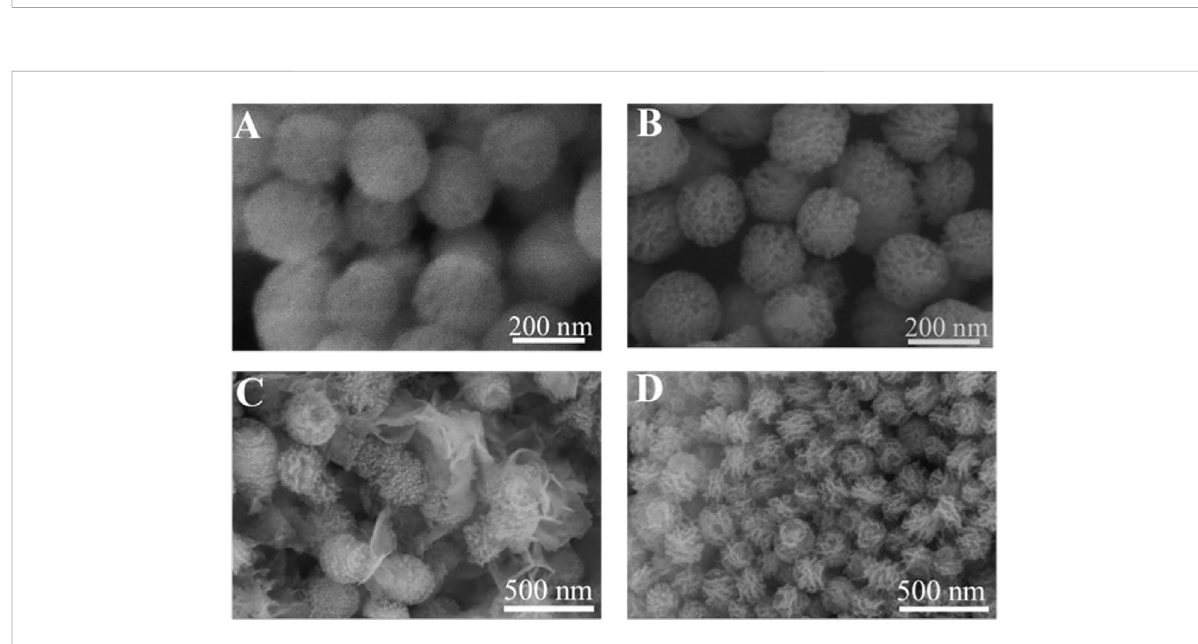
FIGURE 6 SEM image of MBG (A) and MBG@ALG (B) . SEM image of MBG (C) and MBG@ALG (D) after treated with SBF for 7